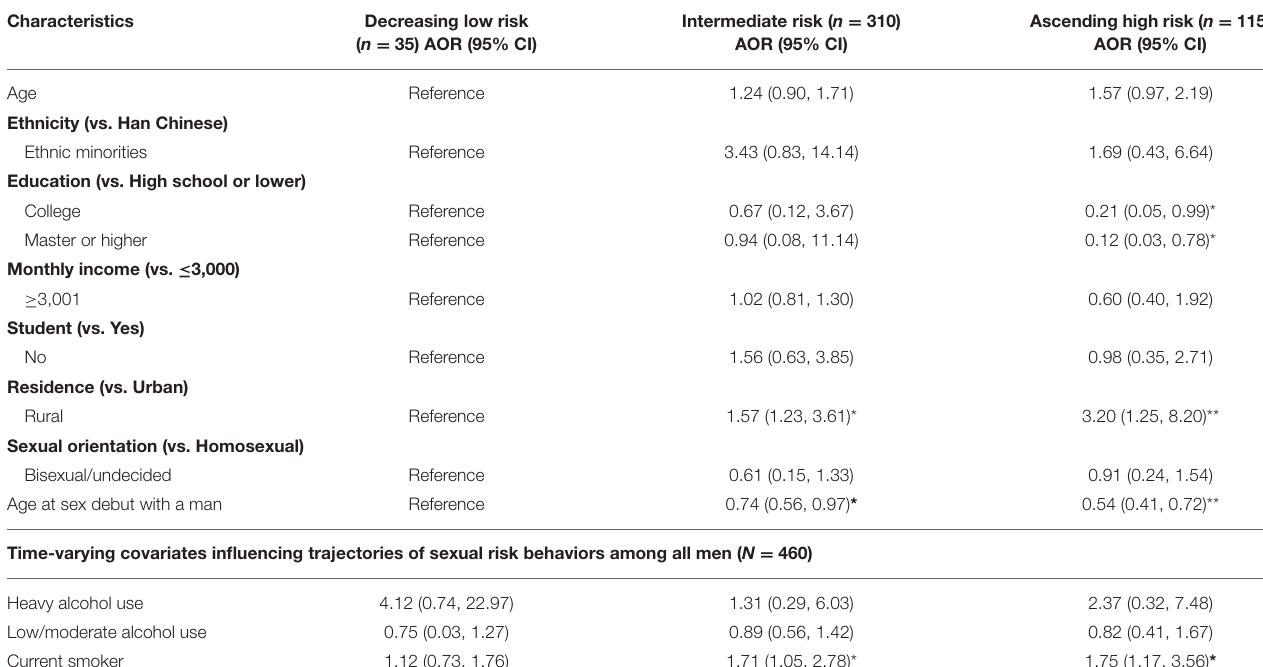
TABLE 4 | Multivariable analysis of risk factors for sexual risk behaviors trajectory group membership among all men ( N = 460).